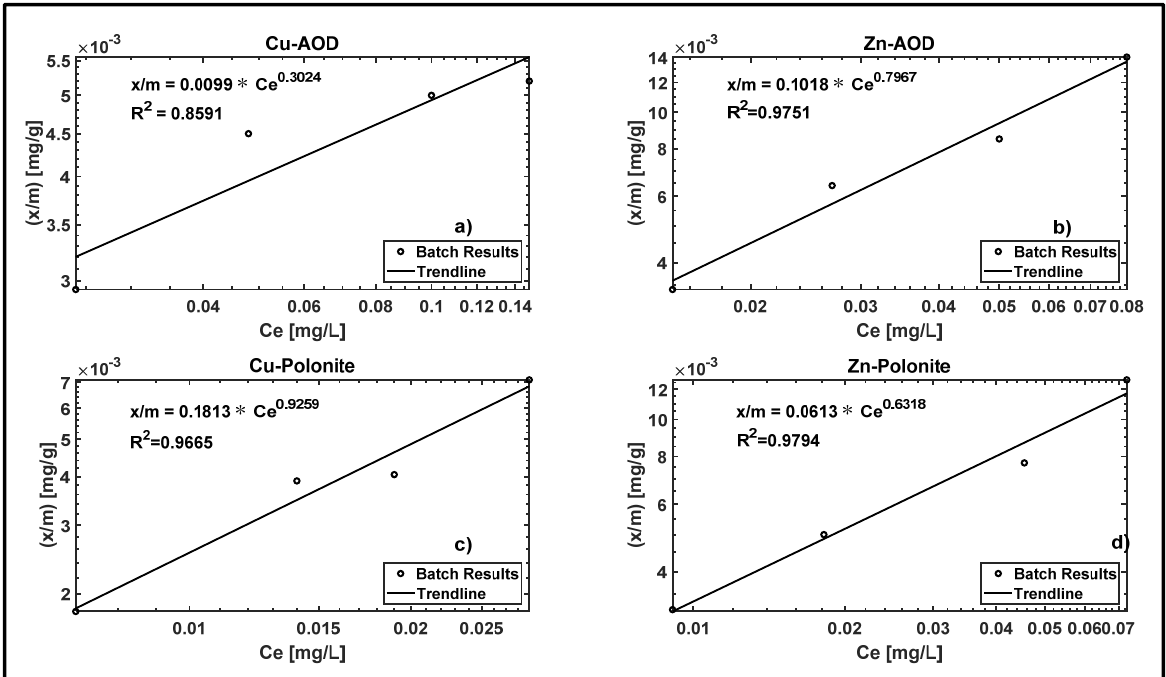
Figure 2. Correlation between batch results and trend line. C e : Equilibrium concentration (mg/L), x/m: Adsorption ratio (mg adsorbate/g media). ( a ) Freundlich isotherm for Cu and AOD, ( b ) Freundlich isotherm for Zn and AOD, ( c ) Freundlich isotherm for Cu and Polonite, and ( d ) Freundlich isotherm for Zn and Polonite.